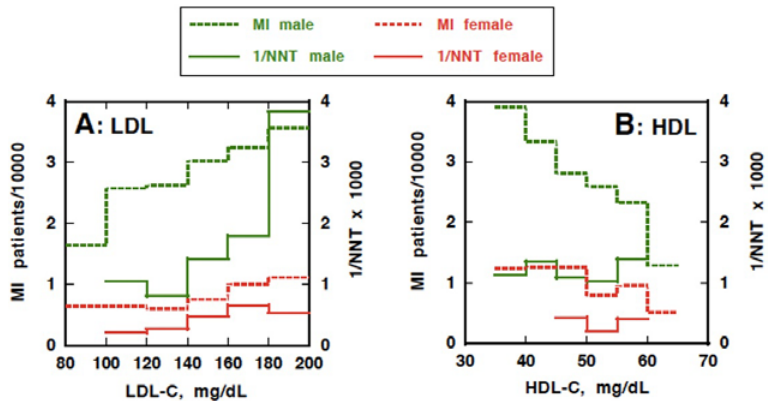
Figure 4. Prevention of ischemic heart disease in Japanese by decreasing LDL-cholesterol (LDL-C) and increasing HDL-cholesterol (HDL-C). Simulation for prevention of myocardial infarction (MI) based on the graphs in Figure 3 and demographic data of Japanese, for males and females, according to the data represented in Tables 2 and 3. Solid lines represent the inverse of NNT (×1000) as an indicator of the treatment efficacy for managing lipoproteins to a target. The value of each horizontal segment is the efficacy when reaching a target LDL or HDL level at the left or right end of the segment, respectively, in all Japanese at ages covered by the JLIT. Each horizontal segment of broken lines represents the number of MI patients when LDL is decreased or HDL is raised to the left end of the